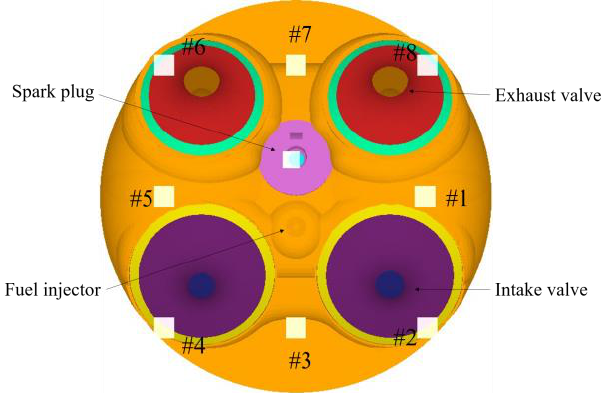
Figure 5. Schematic of monitor points.